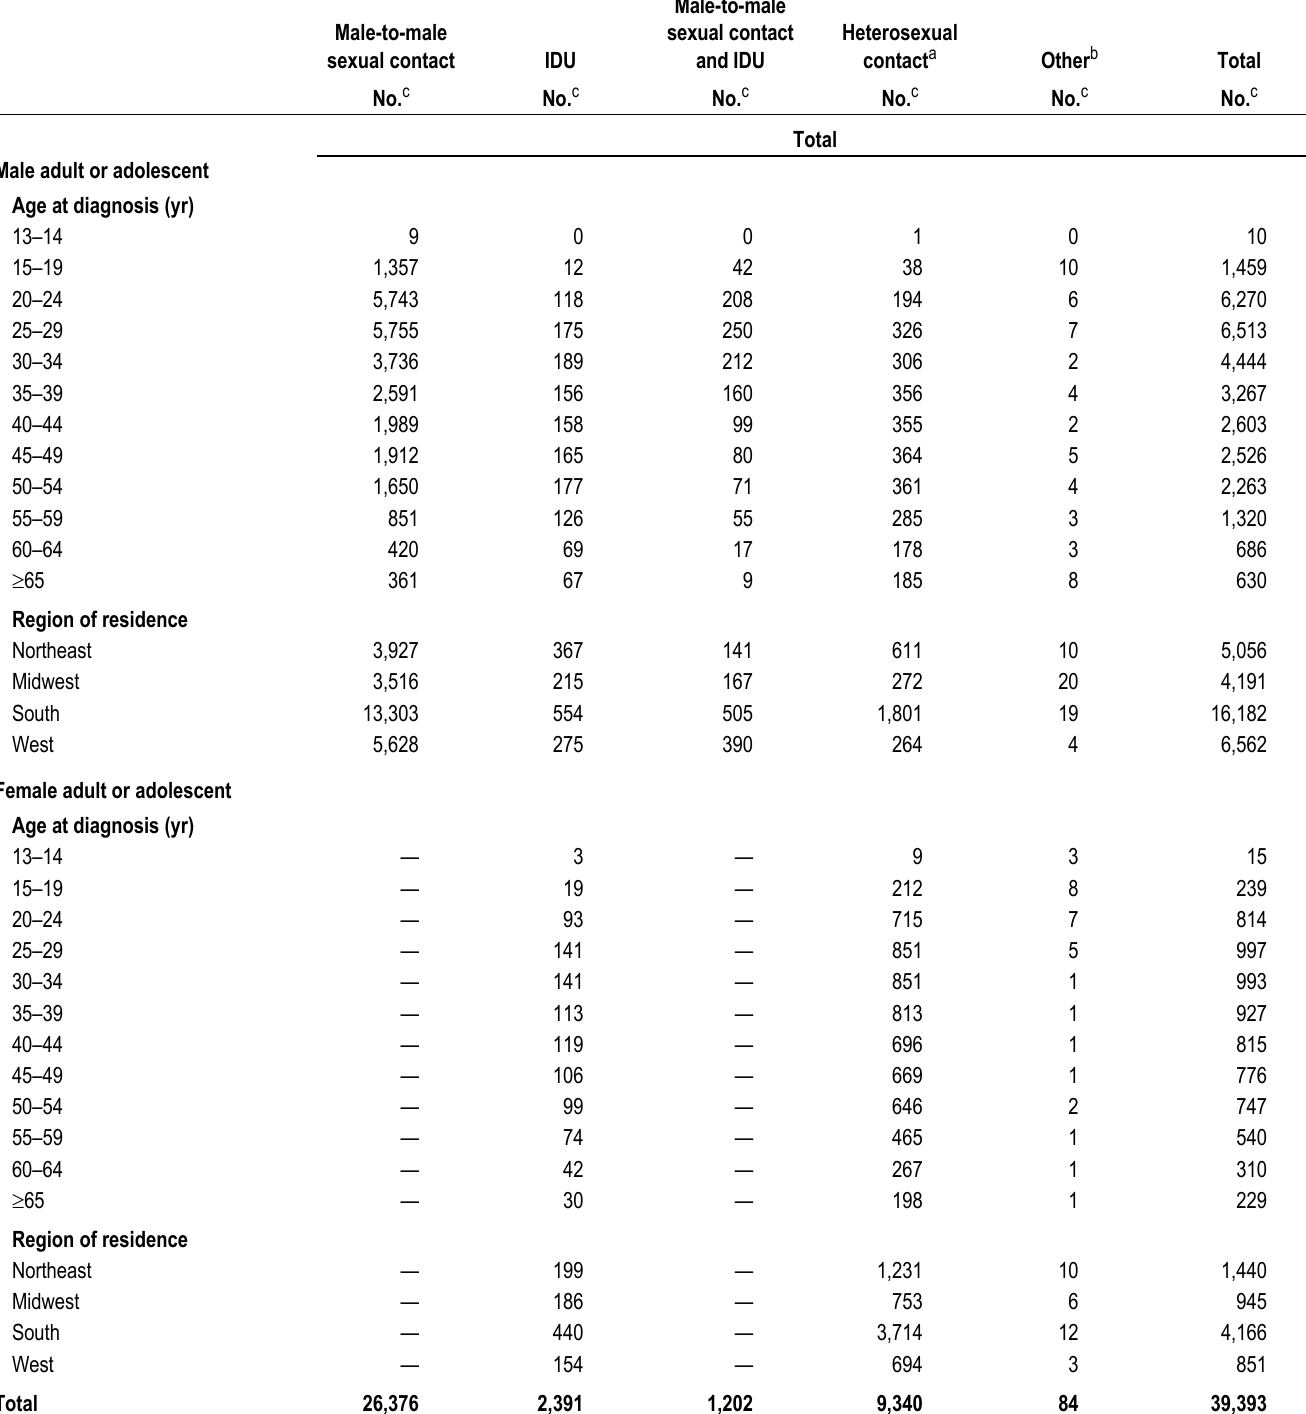
Table 5a. Diagnoses of HIV infection, by transmission category, race/ethnicity, and selected characteristics, 2015—United States